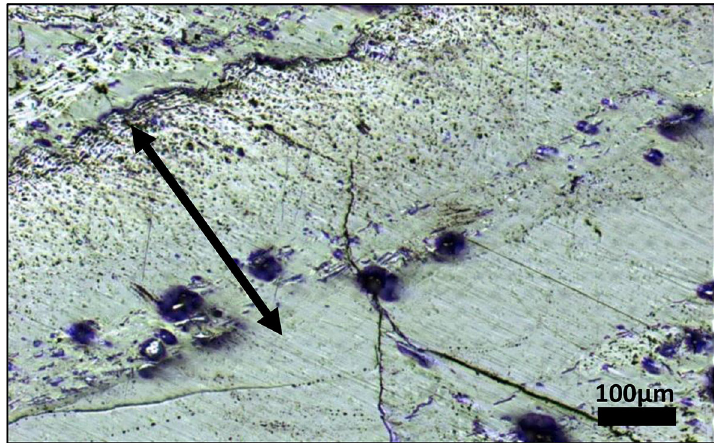
Fig. 6 Fusinite grading into semifusinite and, finally into vitrinite, observed in the inertinite-rich sample. 9 100 magnification, reflected light in air (photomicrograph, H. Dorland). Scale is indicated